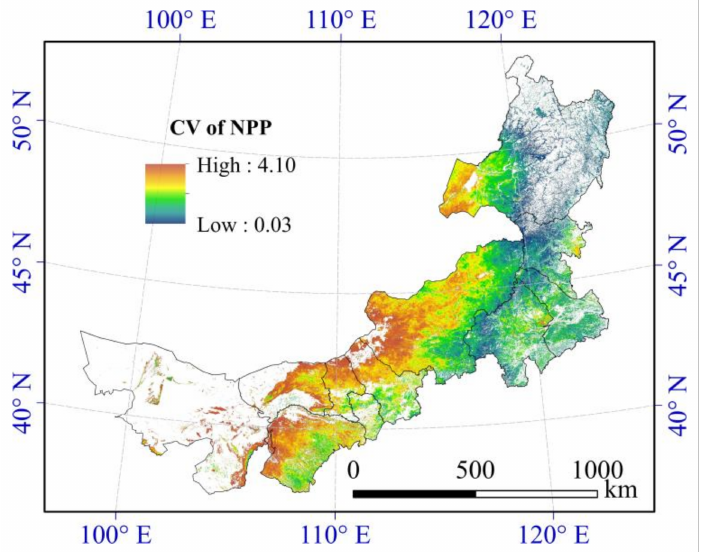
Figure 7. Coefficient of variation of NPP in the Inner Mongolia grassland during 2000–2020.